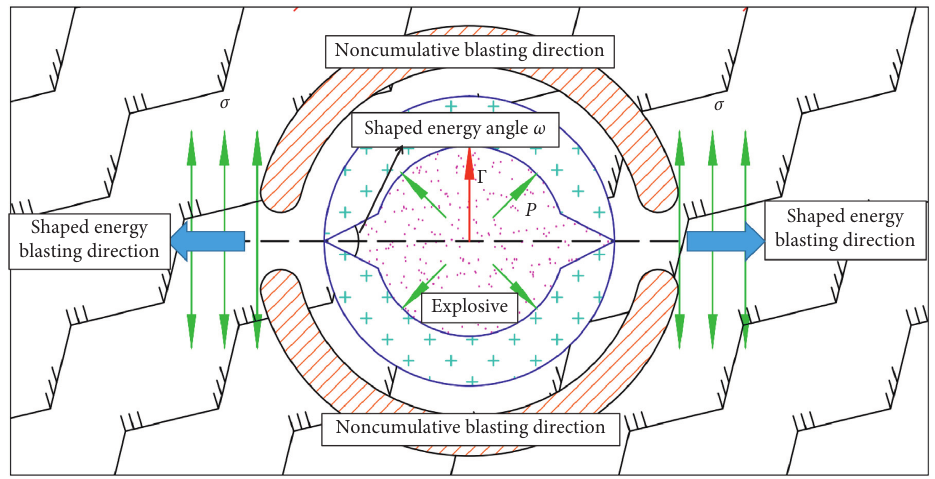
Figure 3: Schematic diagram of bidirectional cumulative tension blasting.